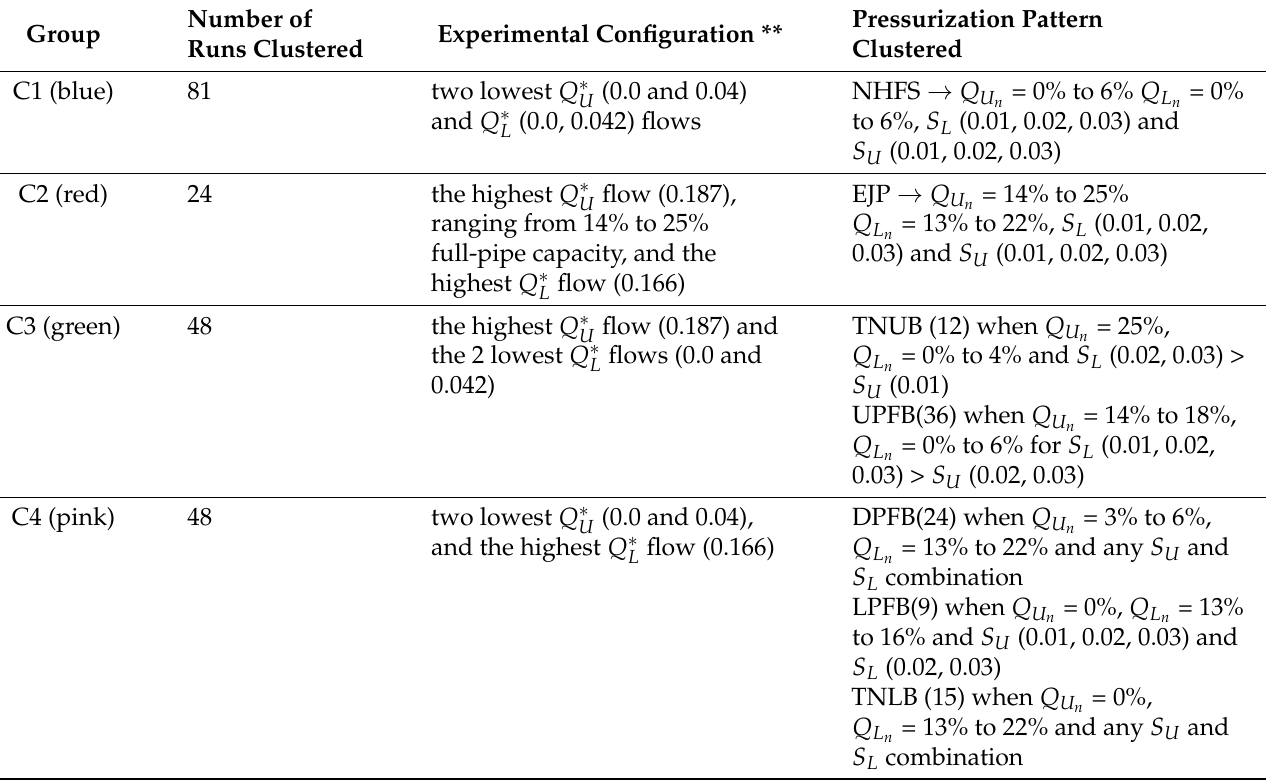
Table 3. Experimental configuration and pressurization pattern according to video record